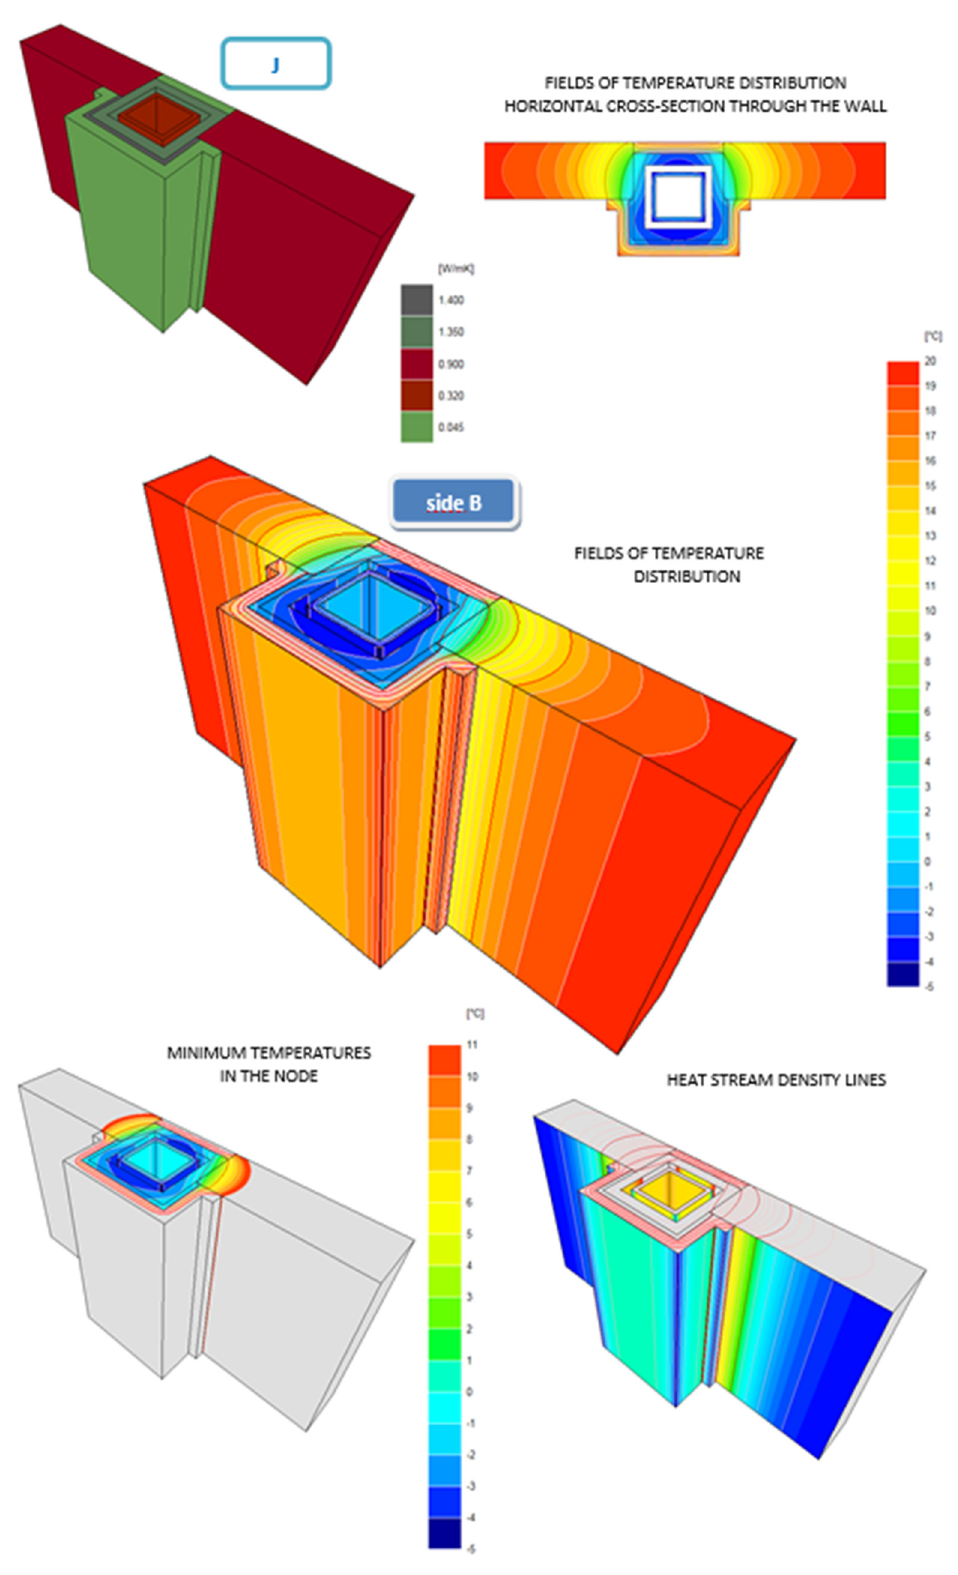
Figure A10. Scheme J: isotherm field distribution, minimum surface temperature, and heat flux distribution.